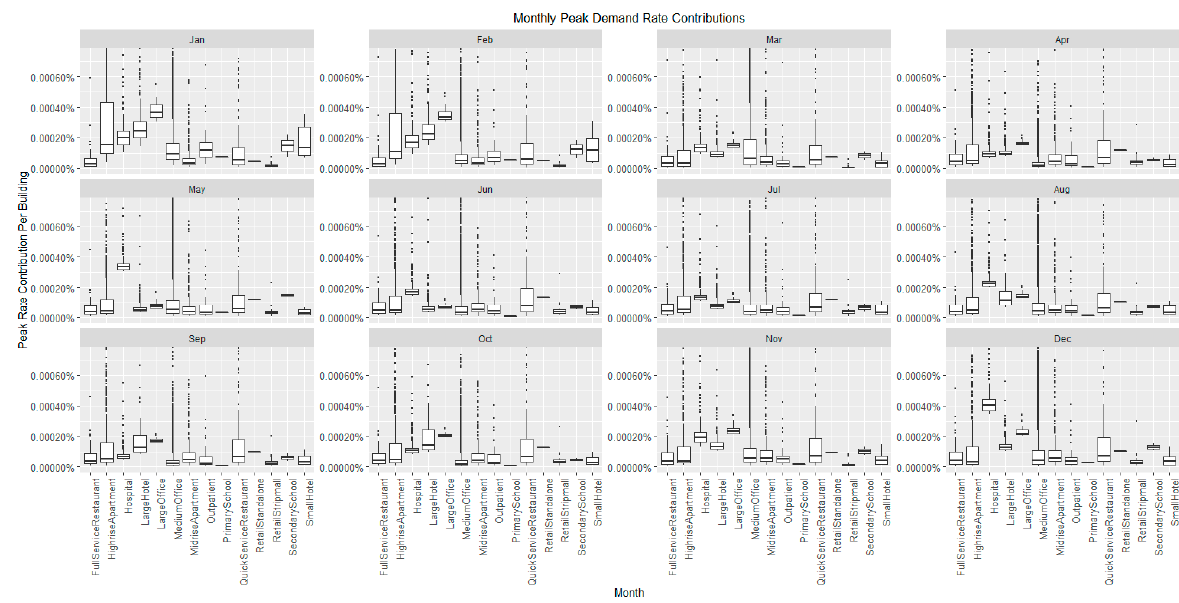
Figure 3. Distribution of potential demand contribution by building type for each month.